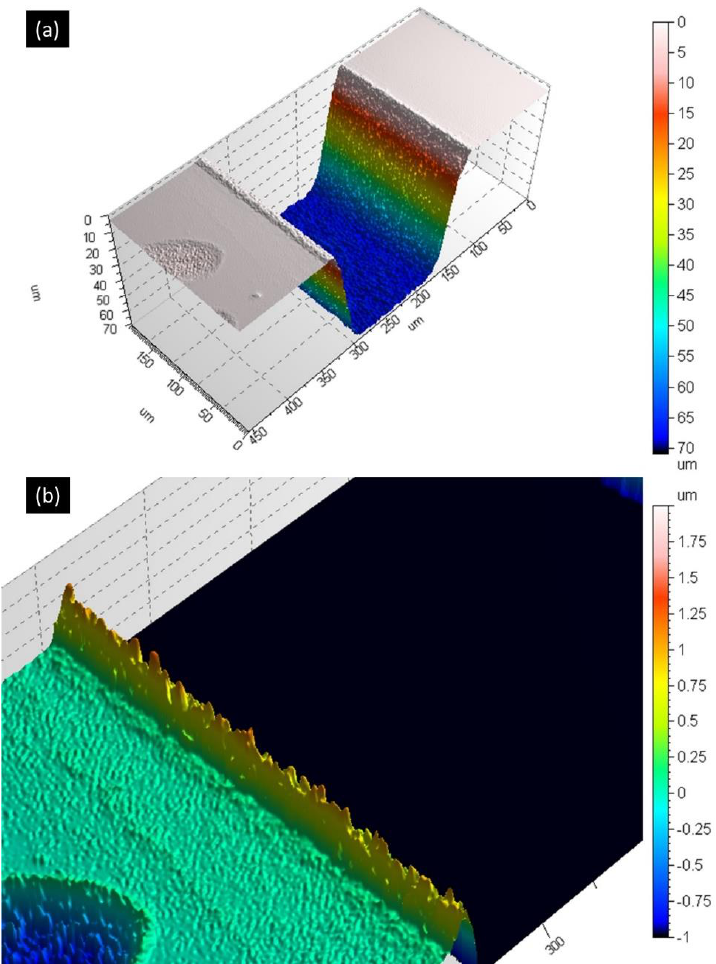
Figure 7. ( a ) Confocal microscope image of a portion of a laser-fabricated microchannel on the silicon surface. The width is ~200 μm and the maximum depth is ~70 μm, ( b ) Zoom-in on the edge of the laser-ablated